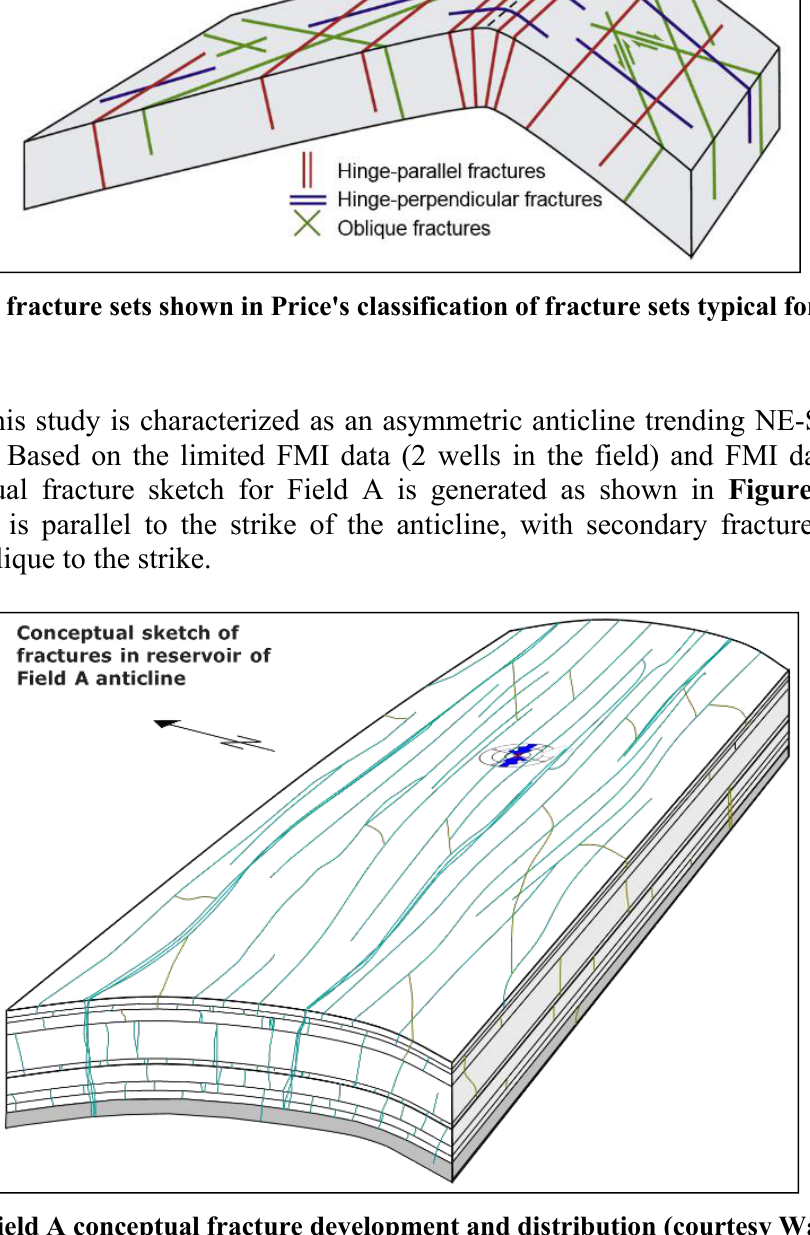
Figure 6—Field A conceptual fracture development and distribution (courtesy Wayne